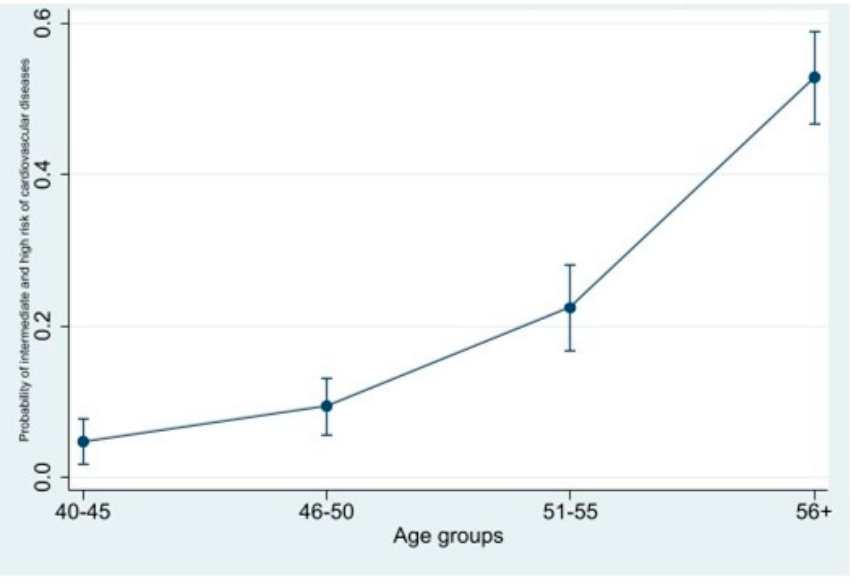
Figure 2. Predictive probabilities of intermediate/high cardiovascular risk among different age groups.